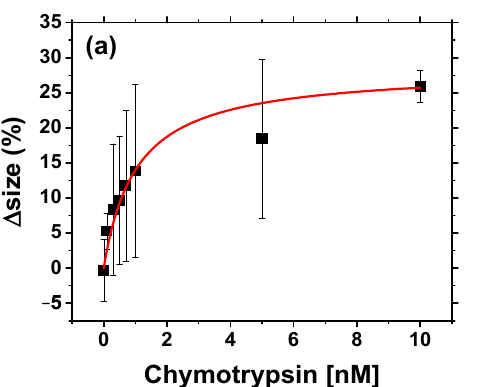
Figure 8. ( a ) The dependence of the changes of Z-average size ( Δ size) vs. concentration of chymotrypsin for suspension of AuNPs modified by β -casein measured by DLS method. The curve represents fit according to reverse Michaelis—Menten model (see above). Δ size = [Z average (30 min) − Z average (0 min)]/Z average (0 min). ( b ) The linear part of calibration curve (red) used for calculation of LOD ( Δ size = 12.47% nM − 1 c + 2.71%, R 2 = 0.87, where c is the concentration of chymotrypsin). For comparison we show first order reaction fit (blue color) ( Δ size = 15.09% − 13.83%e − (c − 0.006 nM)/0.45nM , R 2 = 0.998, where c is the concentration of chymotrypsin). The results represent mean ± SD obtained from 3 independent measurements at each concentration of chymotrypsin.